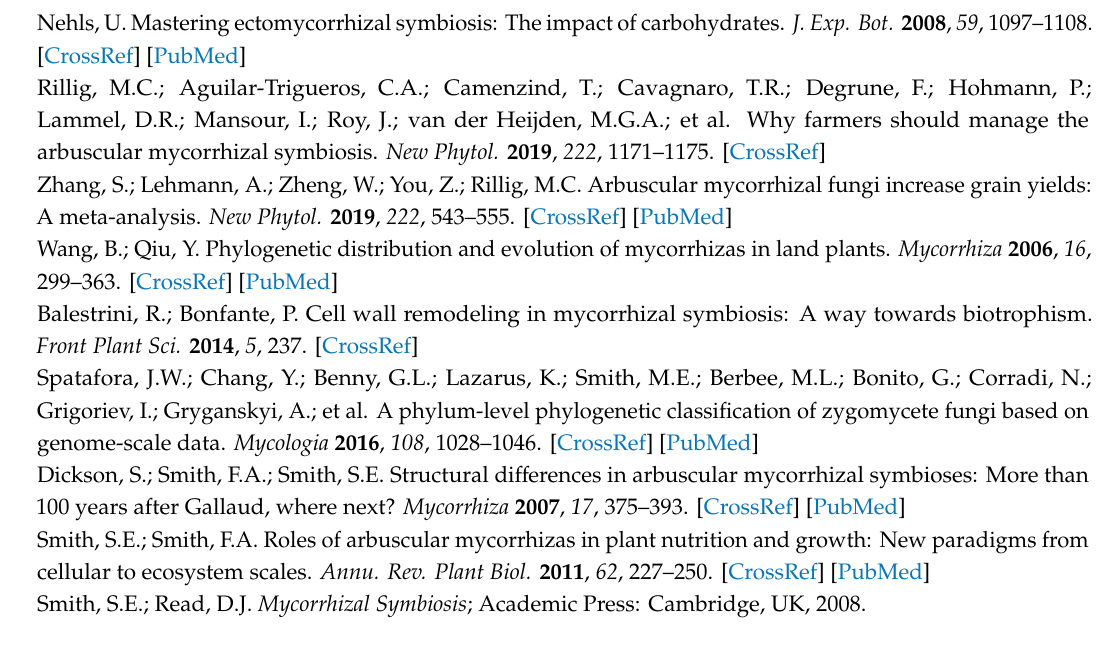
Figure S1: Microscopic observation of young Marchantia paleacea thalli inoculated with various AMF species; Figure S2: Microscopic observation of AMF colonization in Marchantia paleacea thalli and schematic representation of the colonization processes; Figure S3: Di ff erent red pigmentation in the mycothalli of Marchantia paleacea ; Figure S4: Sequence heterogeneity of the mycothalli rDNA Sanger